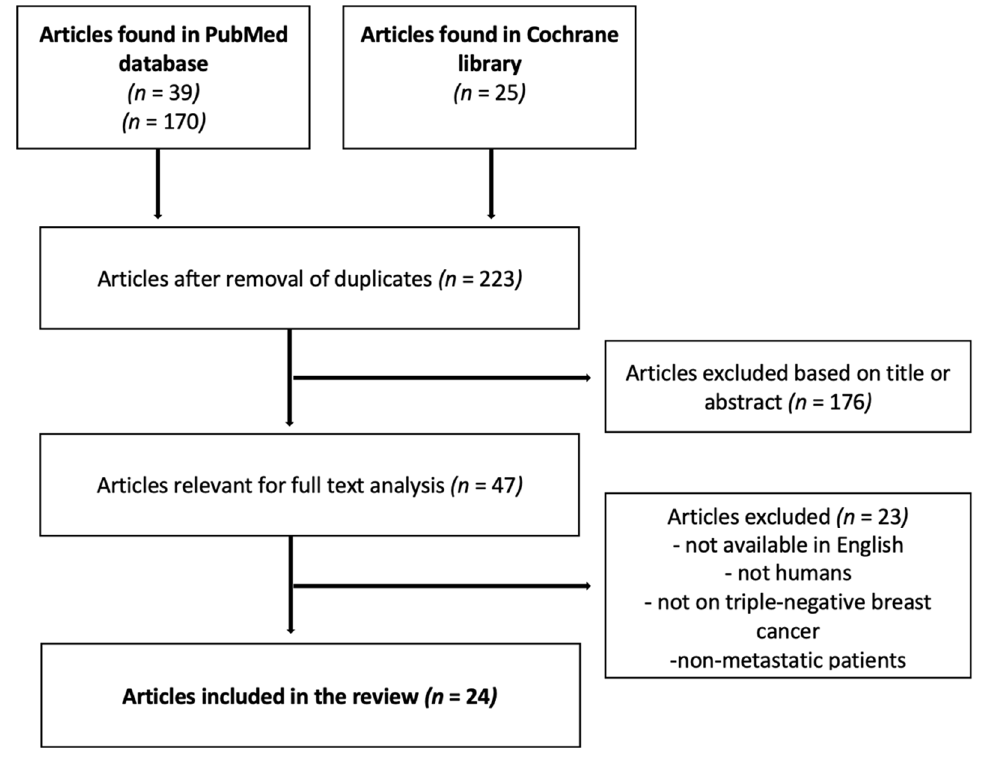
Figure 1. Study selection flow chart. CTC: circulating tumor cell.